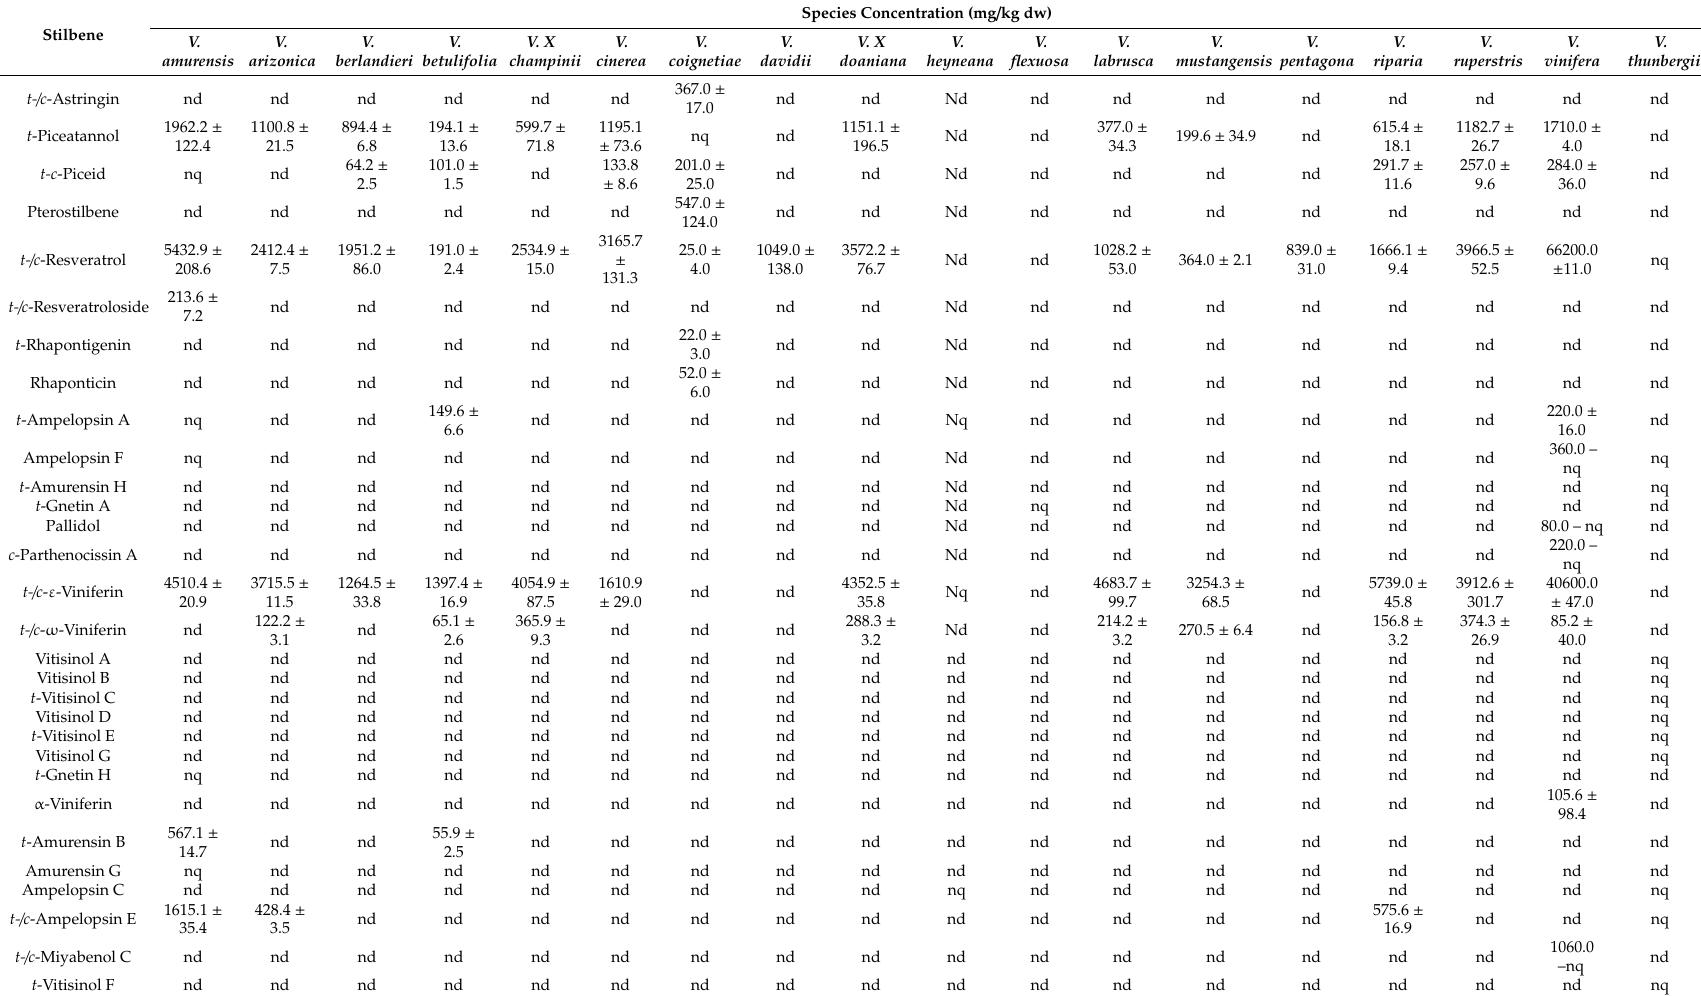
Table 1. Stilbenes described in grapevine canes from di ff erent Vitis species